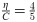
(a)—(c) With different conditions and parameters to compare the numerical simulation and the theoretical prediction of the degree distribution P(k) for the model R.(a) With the condition q = n and after time t = 1000, three groups of the parameters are ηC=45, m0 = m = 3, q = n = 2; ηC=12, m0 = m = 3, q = n = 1; ηC=411, m0 = m = 3, q = n = 2. Blue, red and black solid lines stand for the theoretical degree distribution P(k); red plus, black asterisk and blue diamond stand for the numerical simulation of degree distribution P(k) of three groups respectively. (b) With the condition q < n and after time t = 1000, three groups of the parameters are ηC=710, m0 = m = 8, n = 2, q = 1; ηC=34, m0 = m = 4, n = 3, q = 1; ηC=12, m0 = m = 8, n = 4, q = 1. Blue, red and black solid lines stand for the theoretical degree distribution P(k); red plus, black asterisk and blue diamond stand for the numerical simulation of degree distribution P(k) of three groups respectively. (c) With the condition q > n and after time t = 1000, two groups of the parameters are ηC=12, m0 = m = 4, n = 1, q = 3; ηC=14, m0 = m = 3, n = 1, q = 3. Blue and red solid lines stand for the theoretical degree distribution P(k); red plus and black asterisk stand for the numerical simulation of degree distribution P(k) of two groups respectively. (d) The numerical simulations of degree distribution P(k) with different competition abilities η and the static parameters C = 2, m = 3, n = 2, q = 1.